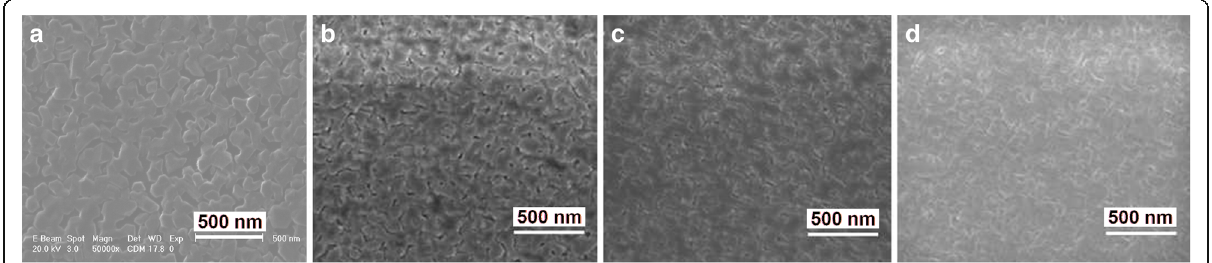
Fig. 3 SEM micrographs of [B(10 nm)/Mg(15 nm)] N =4 multilayers on SiC substrate annealed with HIEB in a SEM with the annealing currents of a 0 mA, b 9.9 mA, c 10.7 mA, and d 12.8 mA,